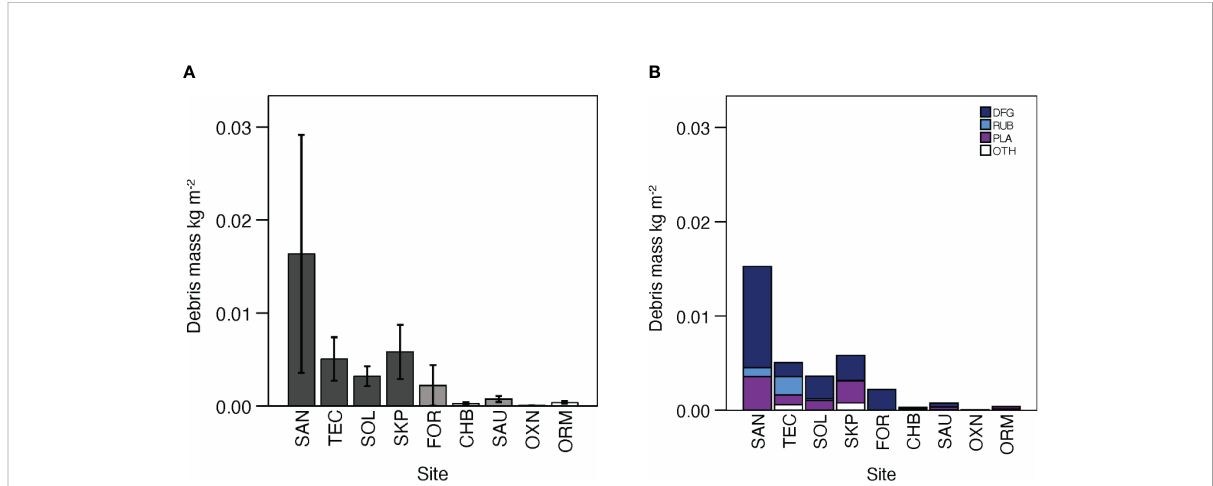
FIGURE 3 The initial density of marine debris (A) , represented as the mass of debris in kg per m 2 collected during the initial collection at Santa Rosa Island (SAN, TEC, SOL, SKP - dark gray), Santa Cruz Island (FOR, CHB, SAU - light gray), and Ventura County mainland sites (OXN, ORM – white). Composition (B) of initial density of marine debris mass represented as the mean mass of debris (kg m -2) collected during the initial collection at each site. Items were classi fi ed as Discarded Fishing Gear (DFG), Rubber (RUB), Other (OTH), and Plastics